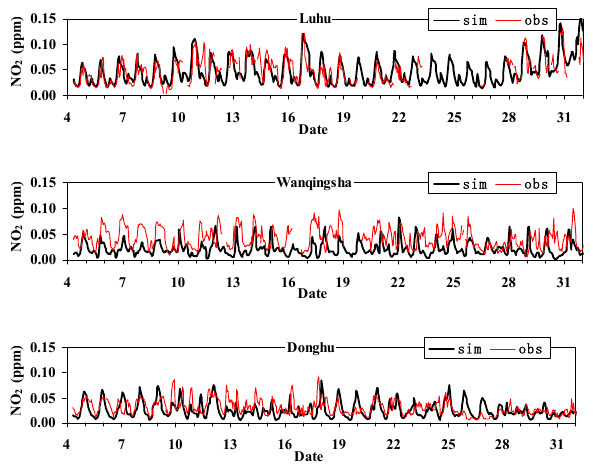
Table 2. Performance statistics of the MM5-simulated meteoro- logical variables against surface observations during 1–31 October